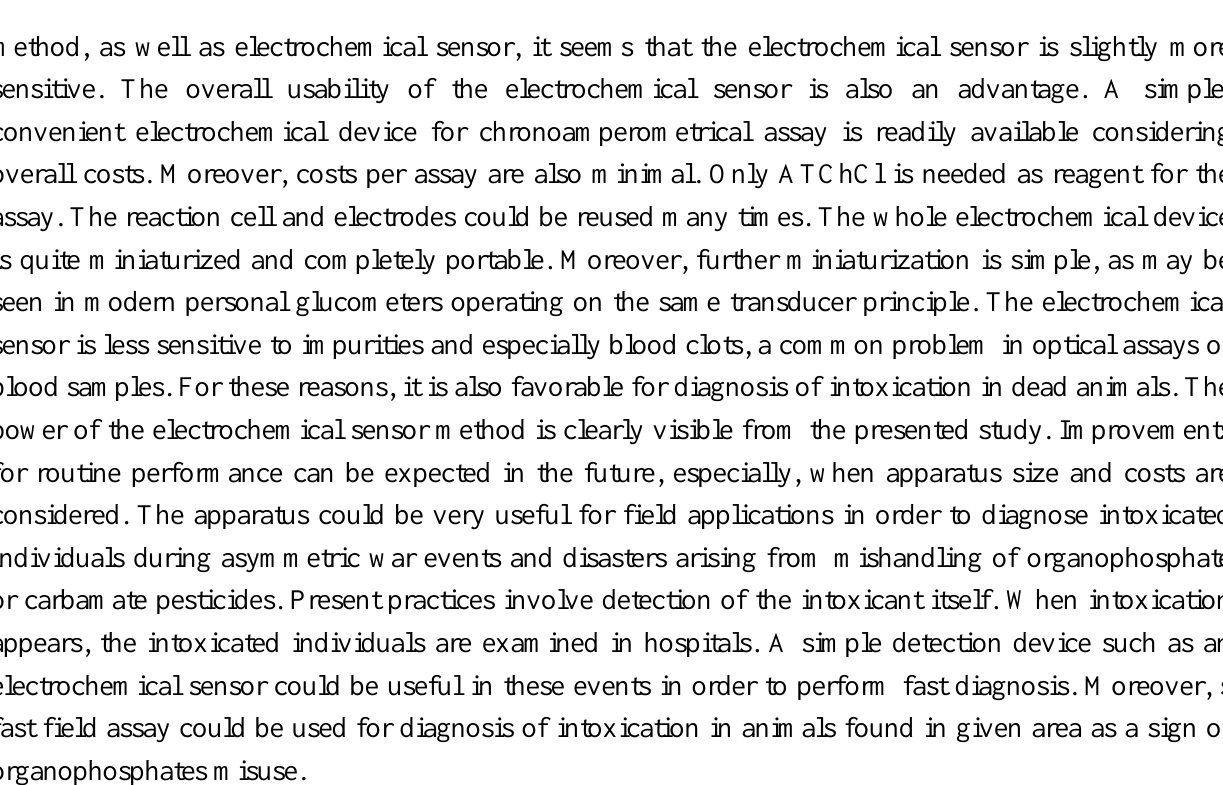
Figure 3. Comparison of electrochemical sensor and Ellman´s assay for diagnosis of intoxication by cholinesterase inhibitors, represented by the nerve agent VX. Percent of inhibition was used as final output provided by both methods. Experimental data from Figure 2 were used for graph